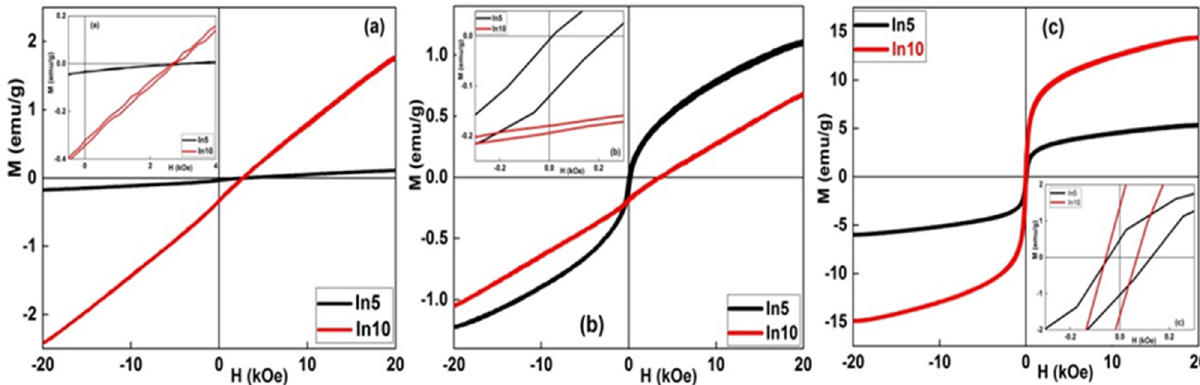
Figure 7. Hysteresis loops, at 300 K, of the as quenched ( a ) and heat ‐ treated In5 and In10 samples after one, ( b ) and three ( c ) heating/cooling cycles. The inset shows the central part enlargement .